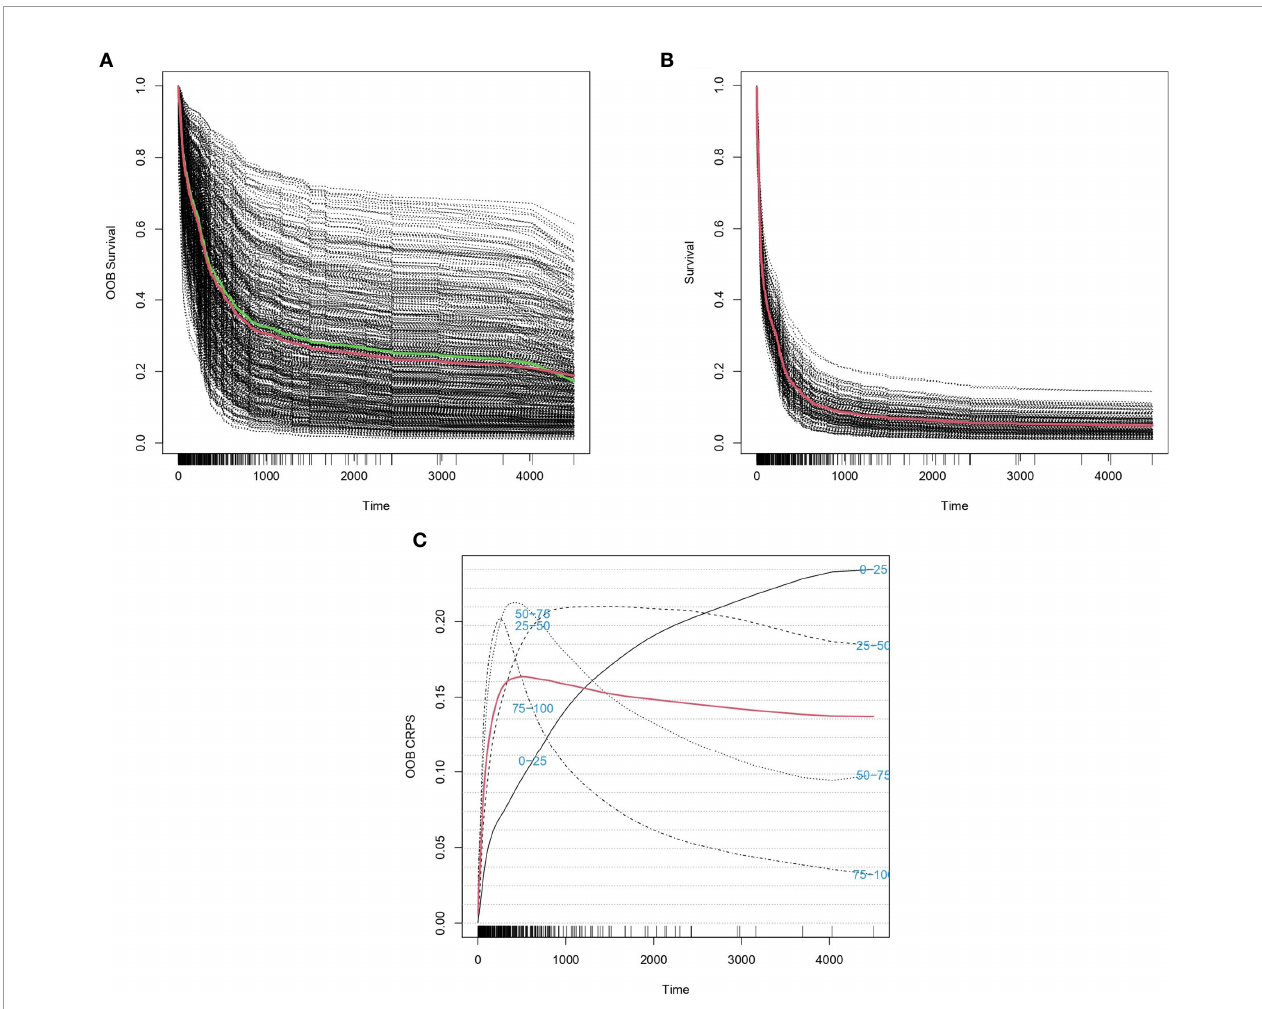
FIGURE 1 | Predicted individual survival curves according to the best random forests model. (A) Out-of-bag survival curves predicted for patients within the training cohort. The thick red line represents overall ensemble survival and the thick green line indicates the Nelson-Aalen estimator. (B) Individual survival curves predicted for patients within the test cohort. The thick red line represents overall ensemble survival. (C) Representation of out-of-bag CRPS over time. Red line is the overall CRPS. Additionally, strati fi ed CRPS by quarters of predicted ensemble mortality are provided. Vertical lines above the x axis represent death